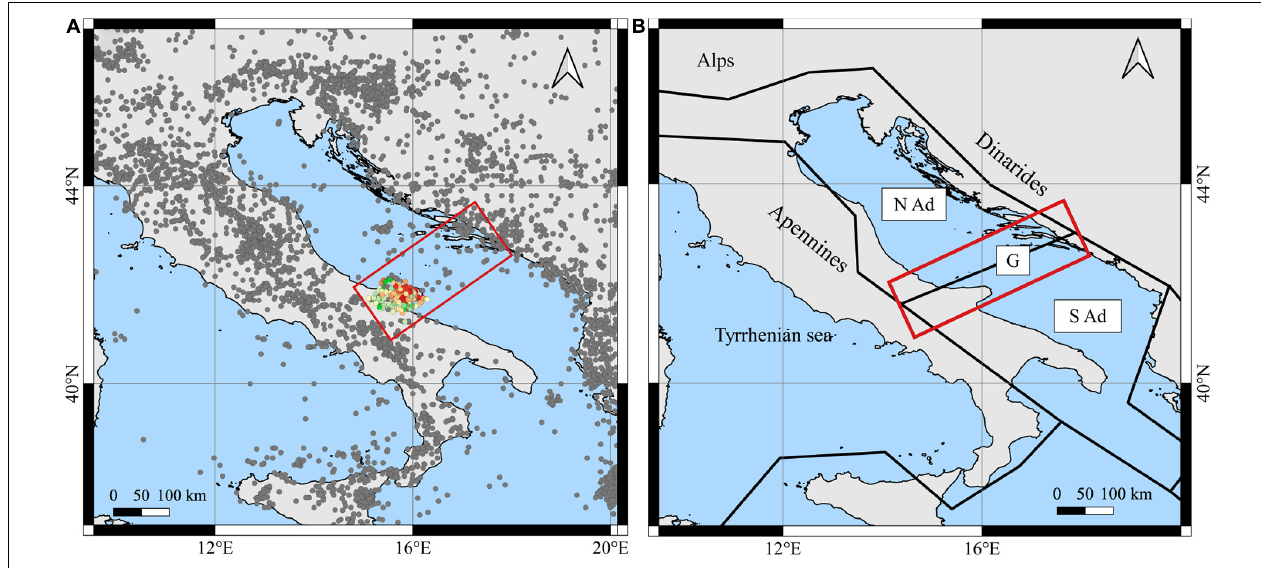
FIGURE 12 | (A) Map of seismicity distribution in the Mediterranean area (gray dots, Giardini et al., 2014). (B) Segments (black solid lines) and modeled blocks from Battaglia et al. (2004) in a geographical map. The Gargano–Dubrovnik fault zone [G], outlined in red, was interpreted as alignment of the splits the Adria plate into two blocks: North Adria [N Ad] and South Adria [S